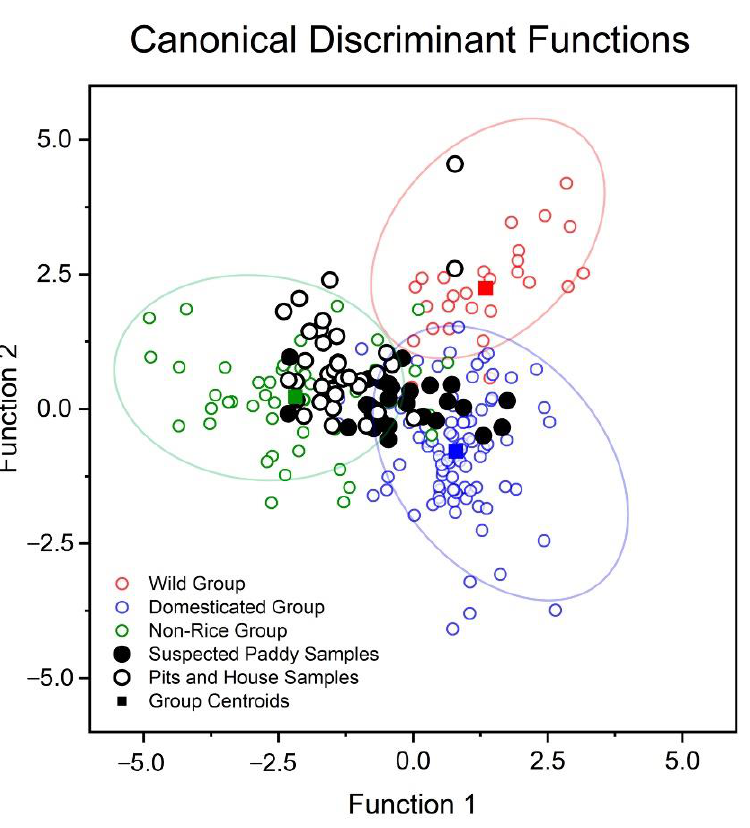
Figure 5. Discriminant results of the Zhangwangzhuang samples (black and white dots) in the context of modern rice paddy samples (colored dots) [31].